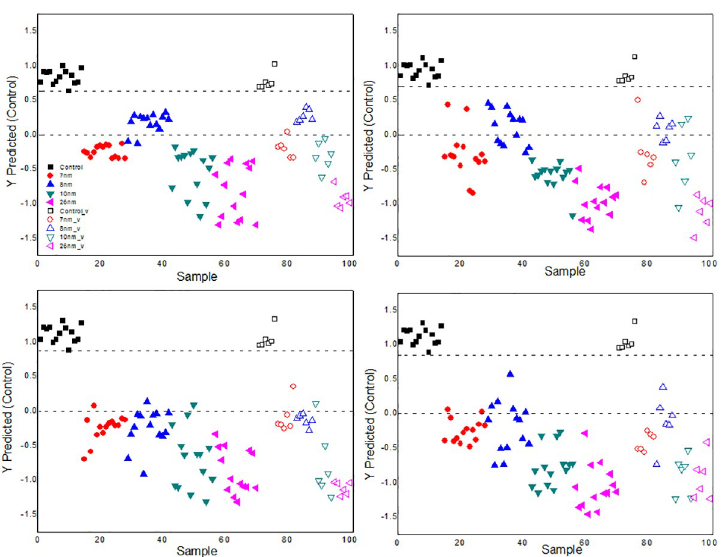
Fig 10. Results of analysis with PLS-DA of the ROE. Behavior of the ROE from plants treated with the NPs and related to the control group. Comparison with class model a) 7 nm, b) 8 nm, c) 10 nm and d) 23 nm. The empty symbols correspond to validation